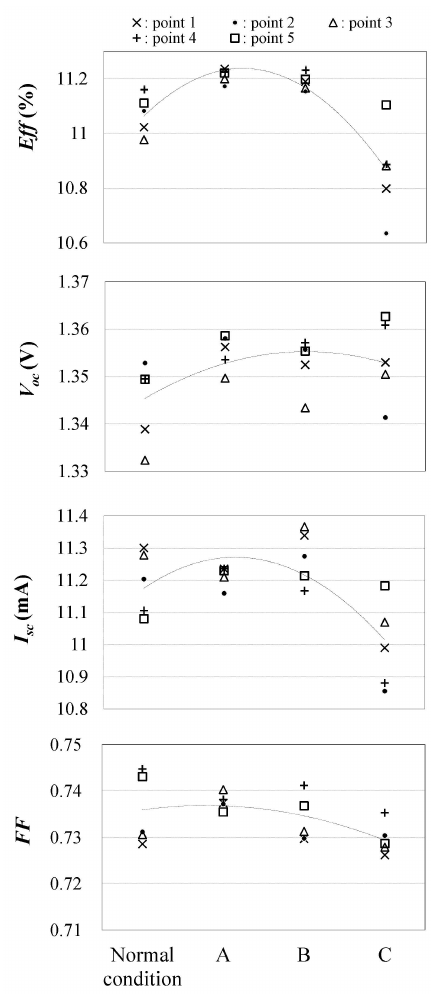
Figure 2. Results of each test cell: normal-condition cell, cell A, cell B, and cell C. For each cell type, five cells were fabricated. Points 1-5 were cells location of substrate. Table 3. Results for each test cell. Each of the values of Eff , V oc , I sc , and FF was averaged for each condition. Error bars are standard deviation ( δ ) calculated for each